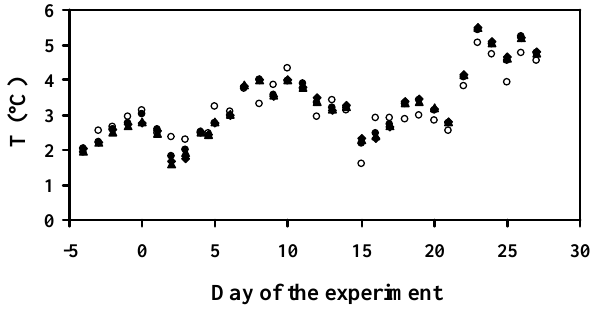
Fig. 5. Mean water temperatures between 0–12m measured during the Svalbard experiment. The three examined mesocosms are shown Mean water temperatures between 0-12 m measured during the Svalbard experiment. The 875 as black symbols, while open circles represent measurements from three examined mesocosms are shown as black symbols, while open circles represent 876 the surrounding measurements from the surrounding fjord. 877